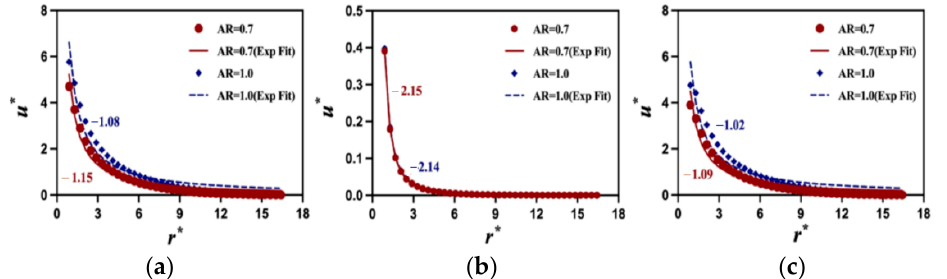
Figure 5. Streamline and velocity (color) induced by squirmer with AR = 0.5 ( left ) and 0.7( right ). ( a ) neutral squirmer ( β = 0). ( b ) puller ( β = 5). ( c ) pusher ( β = − 5).